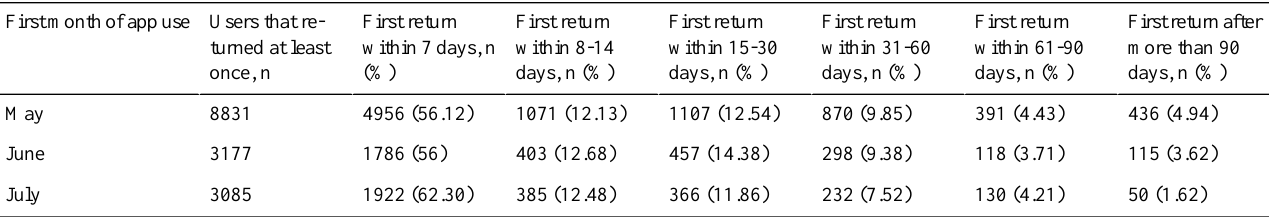
Table 4. Analysis of days between first and second app use among COVID Coach users with at least 2 distinct days of app use, by month of first use.